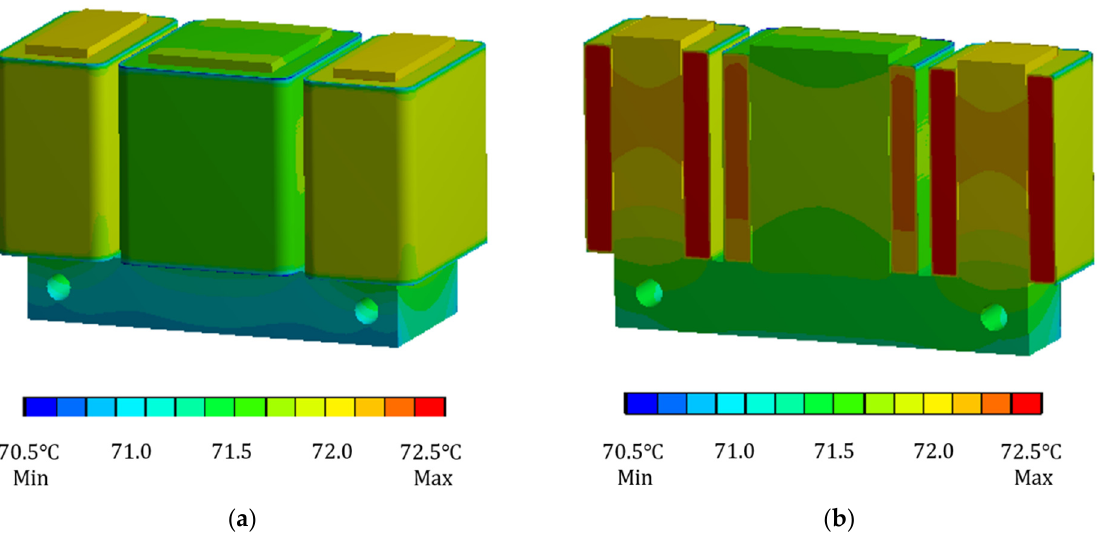
Figure 8. Cloud diagram of steady-state temperature field distribution of electromagnet considering only copper loss. ( a ) Overall diagram. ( b ) Cutaway diagram.